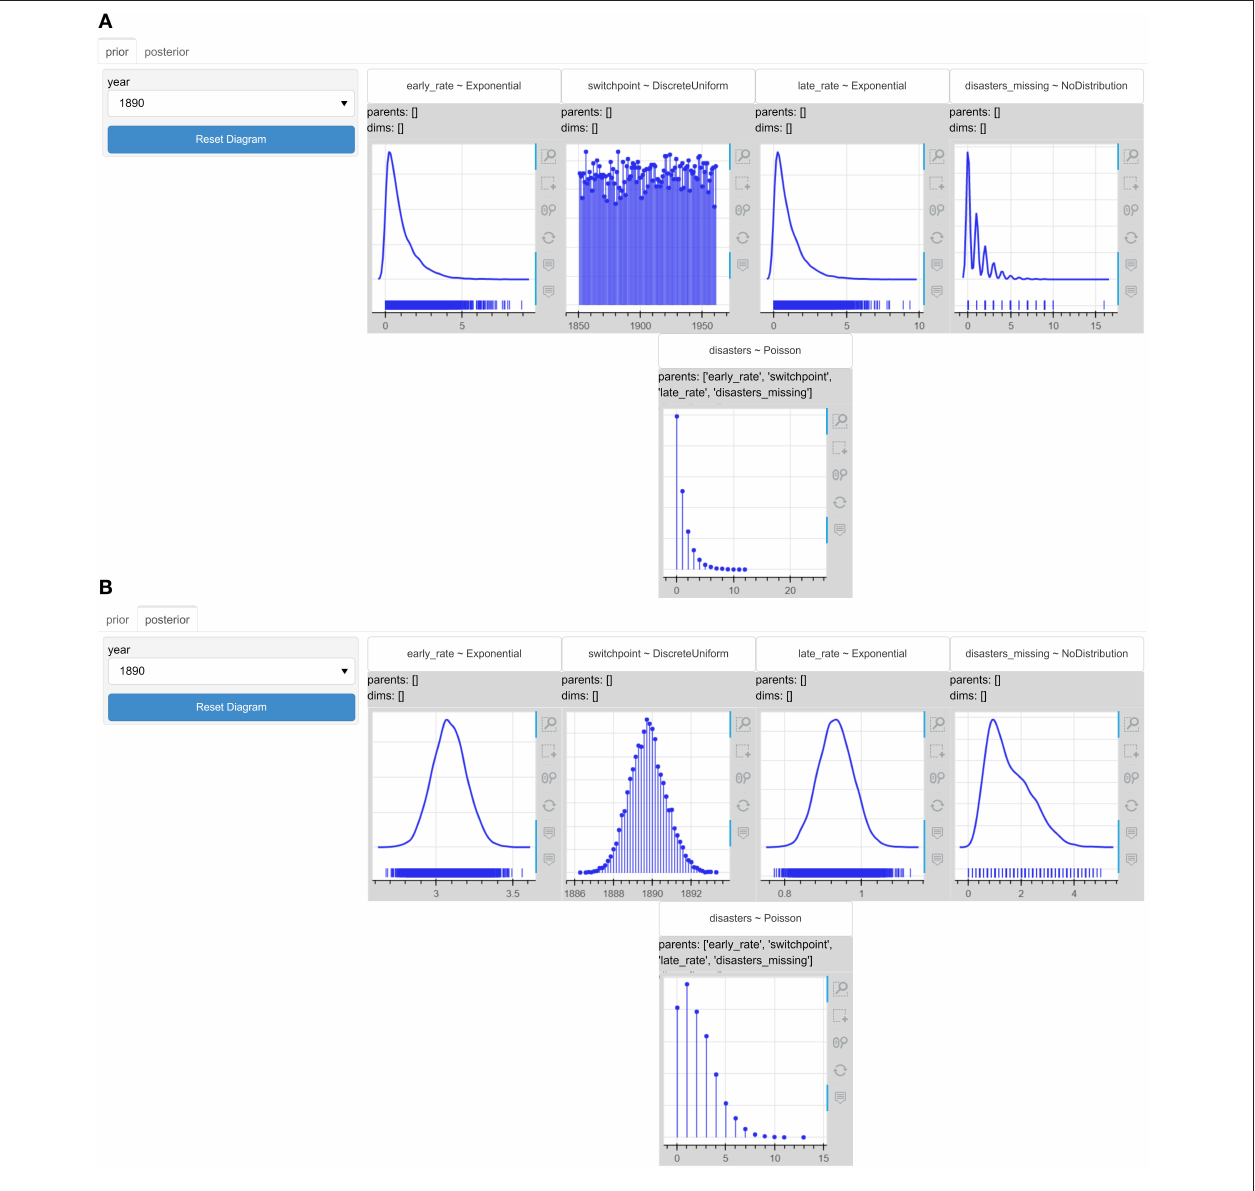
FIGURE 12 | The interactive probabilistic models explorer of the coal mining disasters model. PyMC3 was used for the models’ specification and inference. (A) The prior graphical representation. (B) The posterior graphical representation.